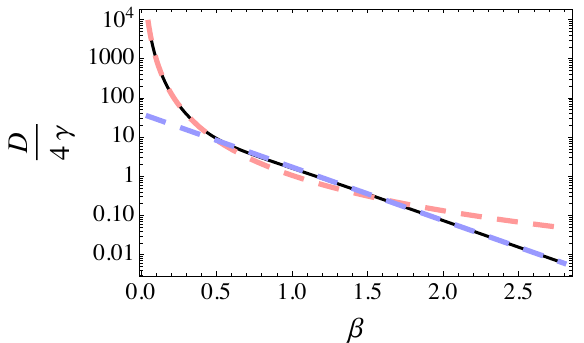
Figure 1. Decoherence rate of two-dimensional Dirac fermions. The numerically-exact decoherence rate evaluated by truncation of eq. (7.12), shown as a solid black line, is compared to the high and low temperature asymptotes in eqs. (7.13) and (7.14) that are shown in light red and blue color,